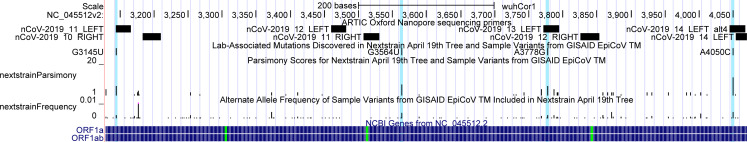
UCSC Genome Browser display of lab-associated variants and ARTIC primers.Bases 3130 to 4070 of the SARS-CoV-2 genome are displayed, containing four lab-associated variants highlighted in light blue. G3145U, A3778G and A4050C overlap ARTIC primer bind sites. An interactive view of this figure is available from http://genome.ucsc.edu/s/SARS_CoV2/labAssocMuts.